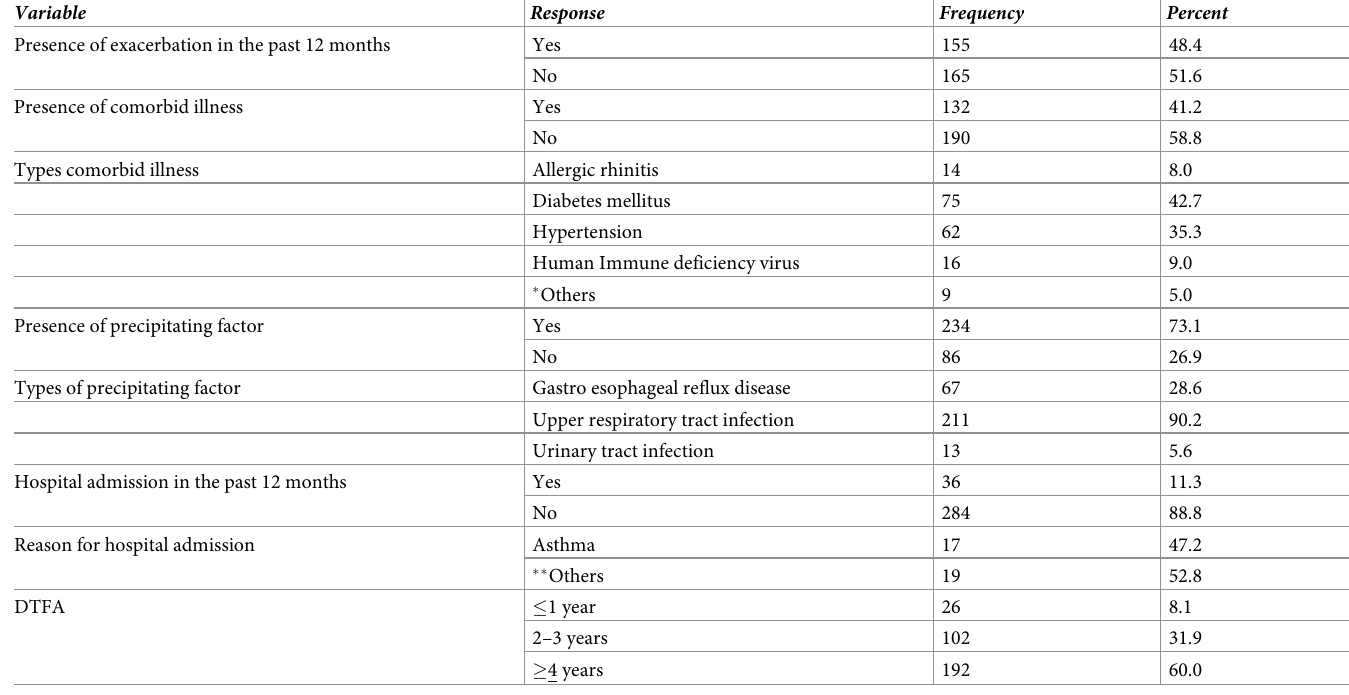
Table 3. Disease related factors among study